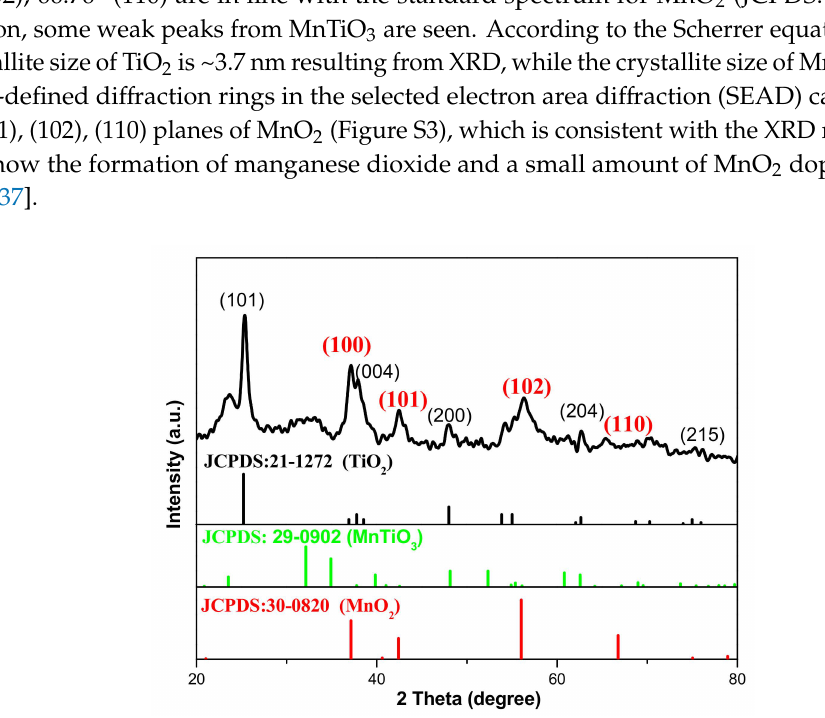
Figure 4. XRD patterns of TiO 2 / MnO 2 and standard XRD patterns of anatase and manganese